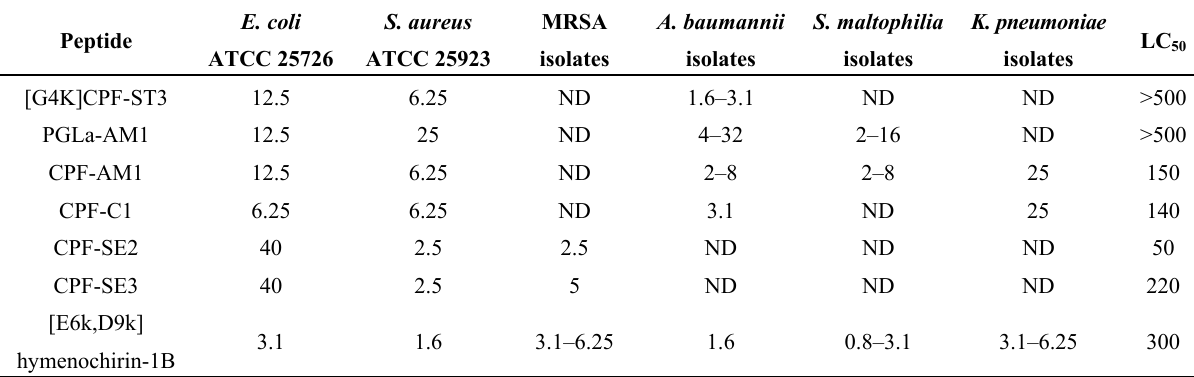
Table 1. Minimum Inhibitory Concentrations (µM) and hemolytic activities against human erythrocytes (µM) of the peptides with greatest therapeutic potential against reference strains and clinical isolates of clinically relevant